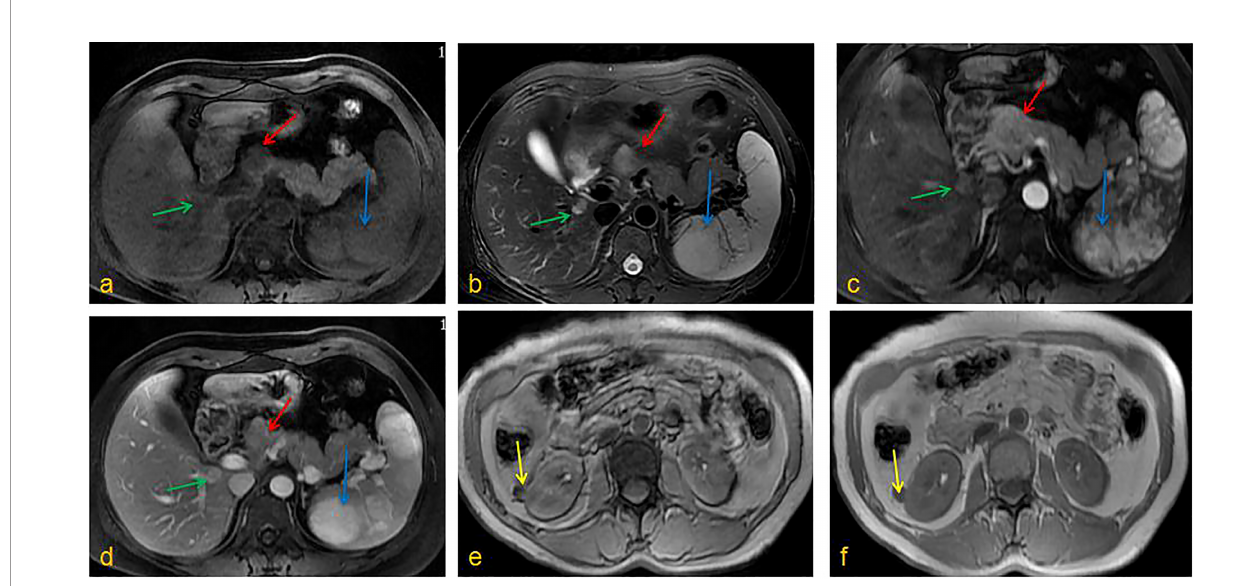
FIGURE 1 | Enhanced MRI of the abdomen. (A) T1WI, (B) T2WI, (C) Enhancement phase, (D) Delay phase: the pancreatic head could be seen a clear outline of about 2.5cm in diameter with long T1T2 signal, the lower segment of the right liver had oval shadow of about 1.4cm in diameter with long T1T2 signal, the spleen showed multiple irregular T1 signals and long T2 signals; (E) T1WI, (F) T2WI, kidneys could be seen round T1 signal and low T2 signal foci, and the enhanced arterial phase showed obvious enhancement. (red arrow: pancreatic tumor; blue arrow: splenic tumor; green arrow: liver tumor; yellow arrow: kidney